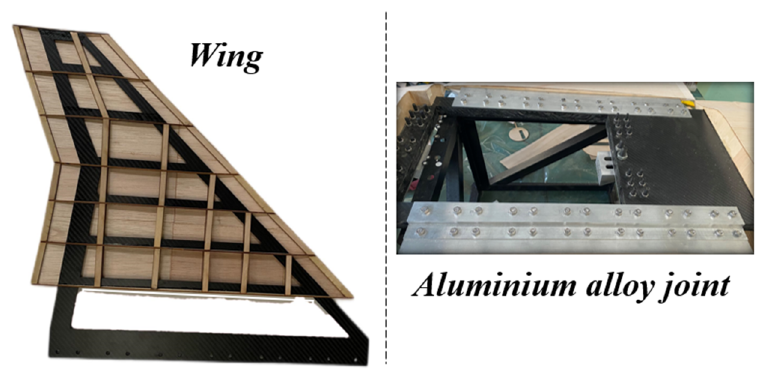
Figure 12. The wing structure and its joint with the fuselage.